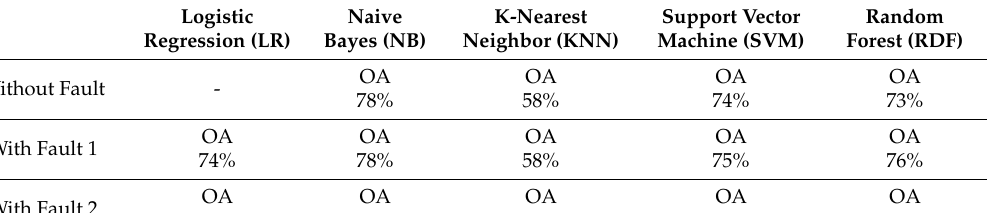
Table 1. The overall accuracy (OA) of each different classifier.